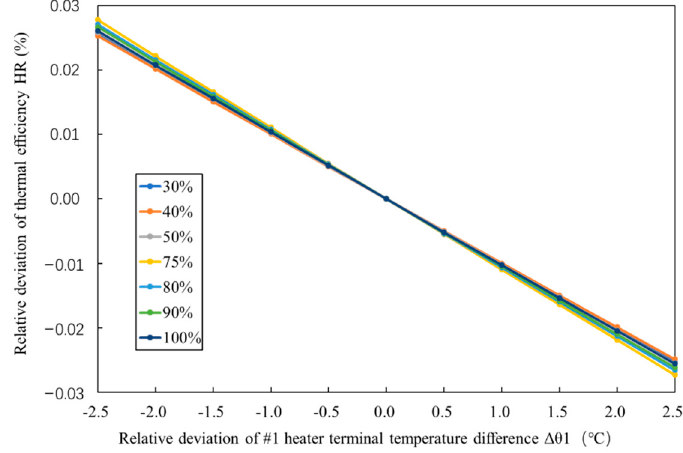
Figure 6. Variation in the relative deviation of thermal efficiency with #1 heater terminal temperature difference disturbance under different output power loads.